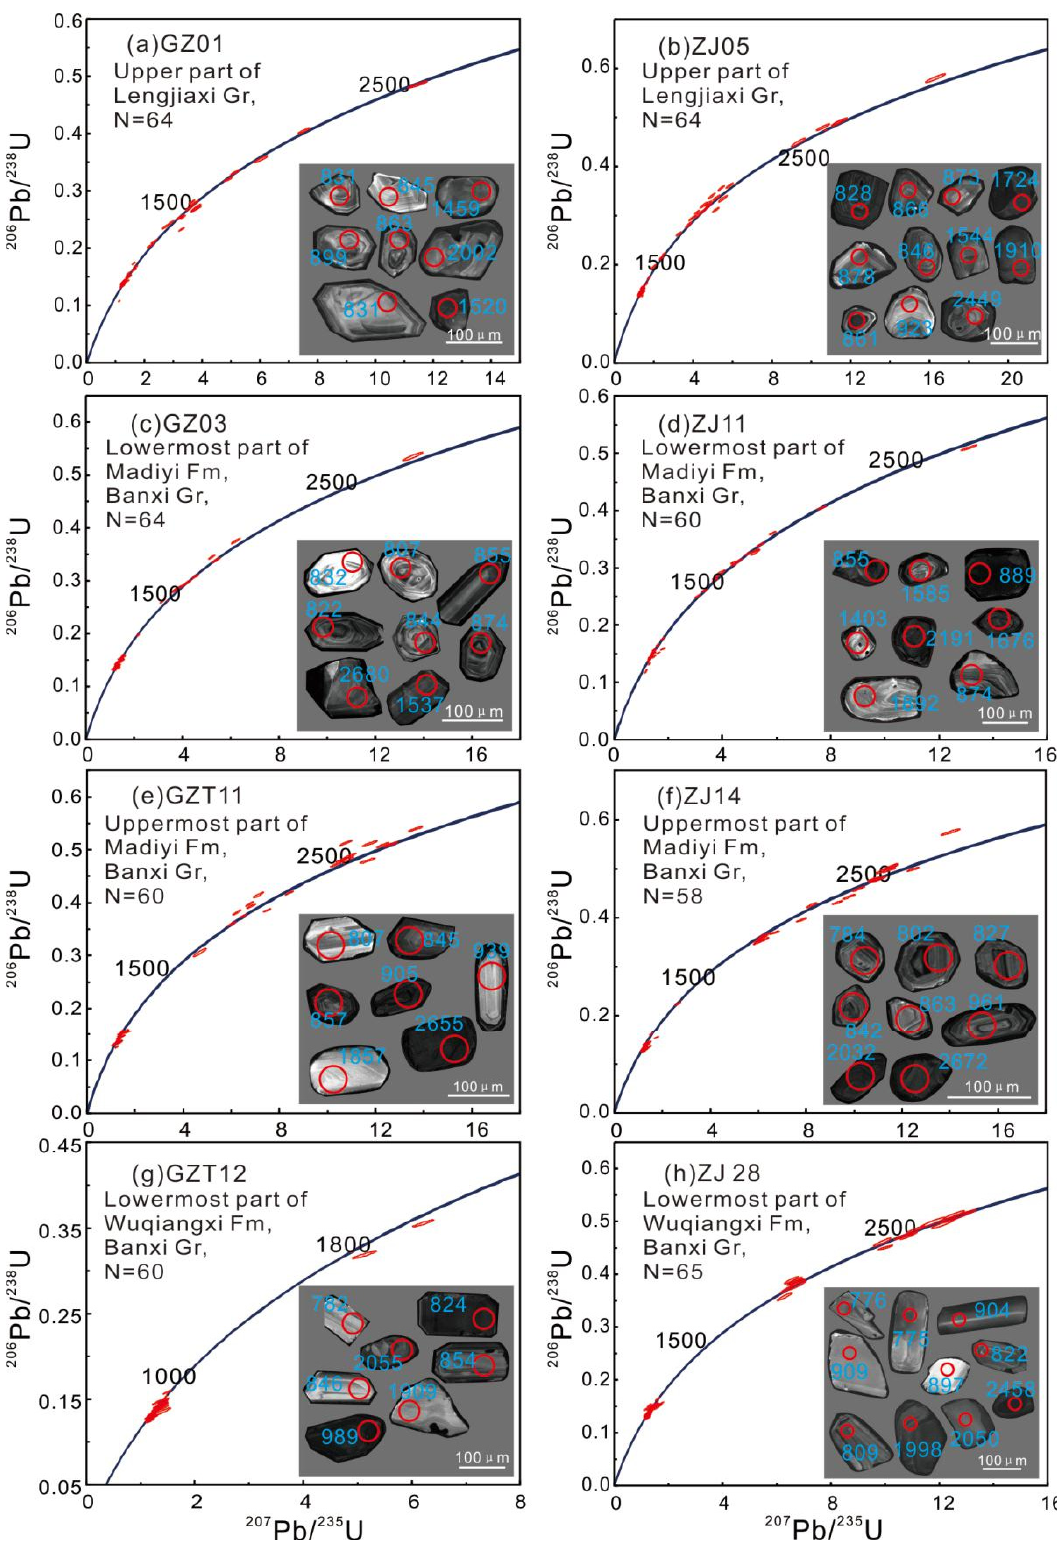
Figure 5. Zircon U–Pb concordant diagrams for studied samples. Inserted diagrams show repre- sentative CL images of analyzed zircon grains. ( a ) Sample GZ01; ( b ) sample ZJ05; ( c ) sample GZ03; ( d ) sample ZJ11; ( e ) sample GZT11; ( f ) sample ZJ14; ( g ) sample GZT12; ( h ) sample ZJ28.